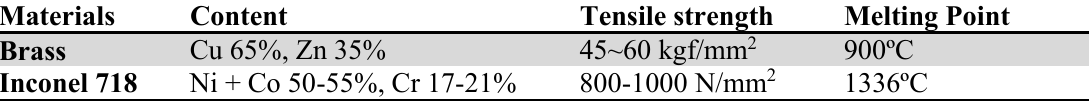
Composition of the tool and work-piece material